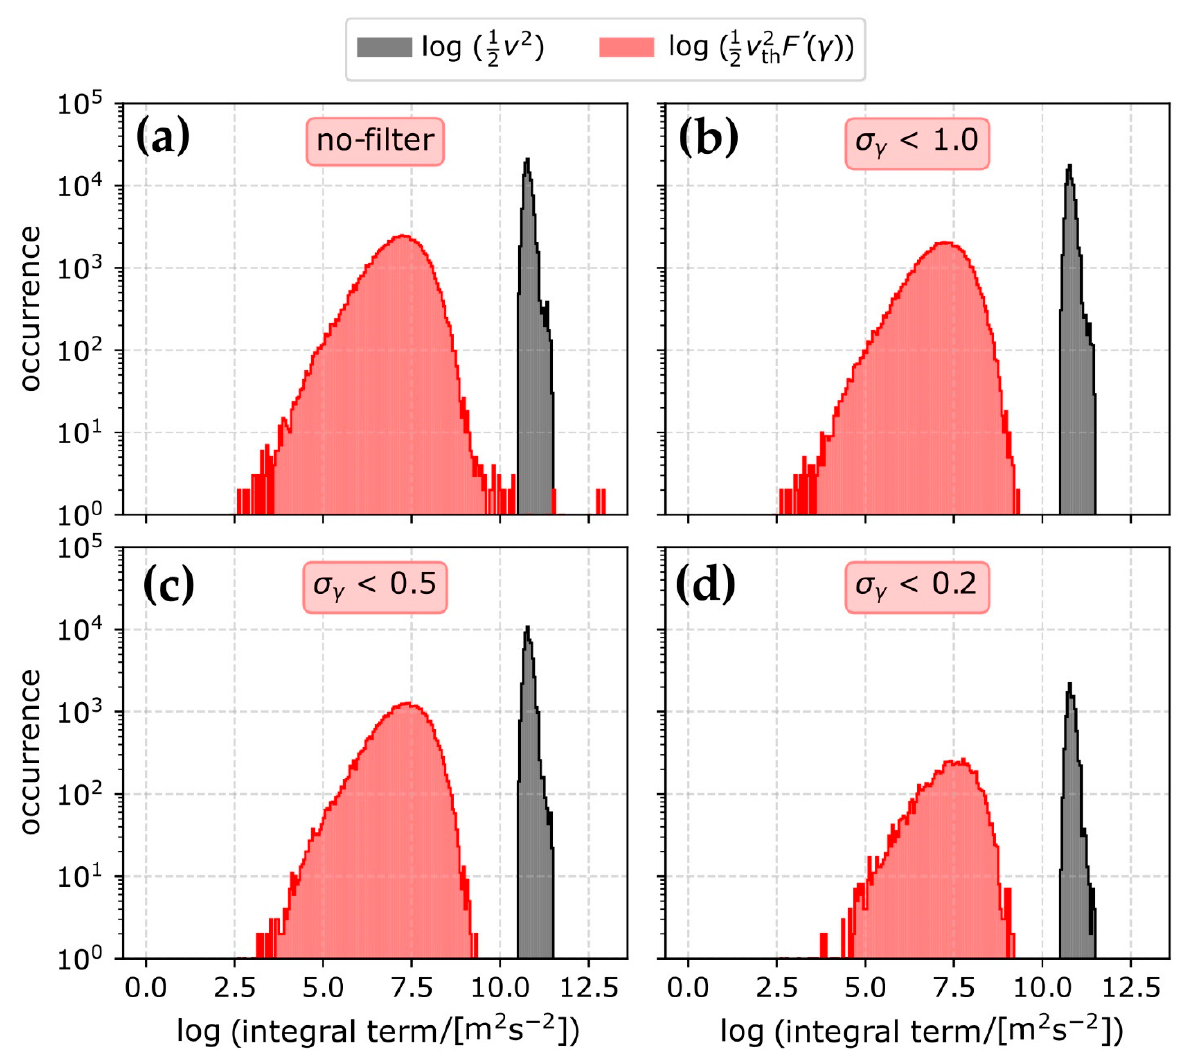
𝑣 (cid:2870) and (red) (cid:2869) 𝑣 (cid:2930)(cid:2918)(cid:2870) 𝛾ln (cid:3082) ( (cid:3096) ) terms of the complete Bernoulli integral for solar wind protons Figure 7. Histograms of (grey) (cid:2869) (cid:2870) (cid:2870) (cid:3096) ∗ at 1 au observed by Wind during 1995. We present the cases for which we take into account ( a ) all σ γ values, ( b ) only data with σ γ < 1, ( c ) σ γ < 0.5, and ( d ) σ γ < 0.2.